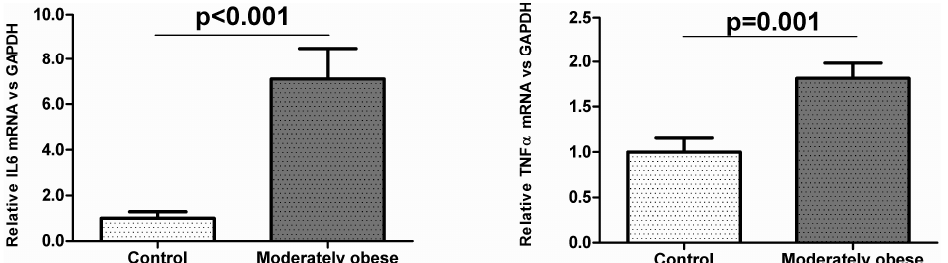
Figure 1. Expression of genes involved in lipogenesis, FA oxidation and inflammation in control ( n = 35) and moderately obese women ( n = 55) in subcutaneous adipose tissue. Student’s t -test was used to determinate differences between groups. Data are expressed as mean ± SD. The mRNA expression was calculated relative to the control group, whose mRNA expression was set to 1.0. ACC1, Acetyl-CoA carboxylase 1; FAS, Fatty acid synthase; IL6, Interleukin 6; PPAR α , Peroxisome Tumor necrosis factor alpha.